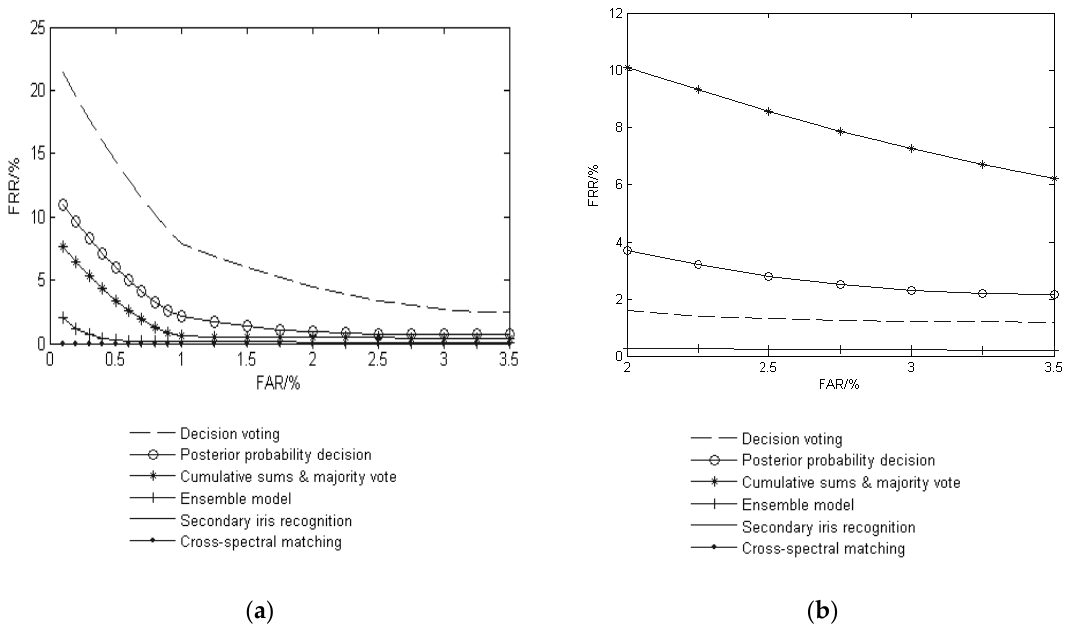
Figure 14. The ROC curve of JLU-3.5: ( a ) Global map; and ( b ) Partial magnification.